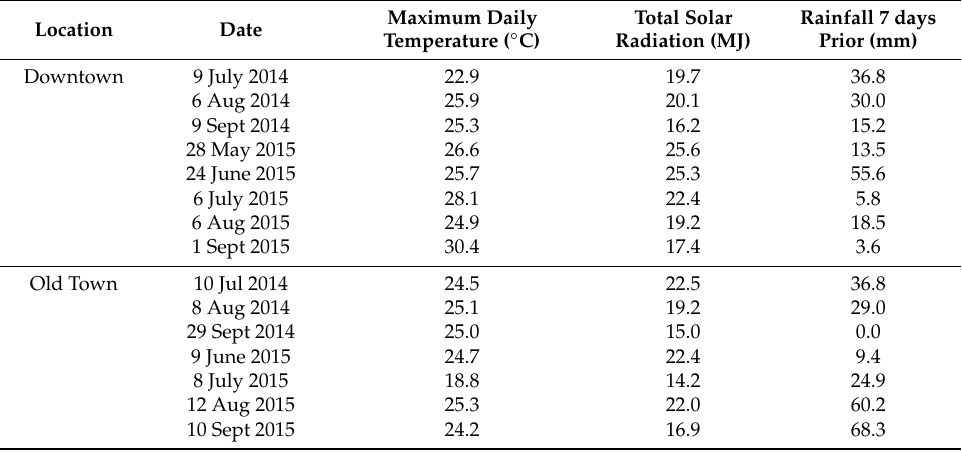
Table 2. Maximum daily temperature, total solar radiation and rainfall one week prior to leaf water potential measurements for street trees in Lansing, MI, USA in 2014 and